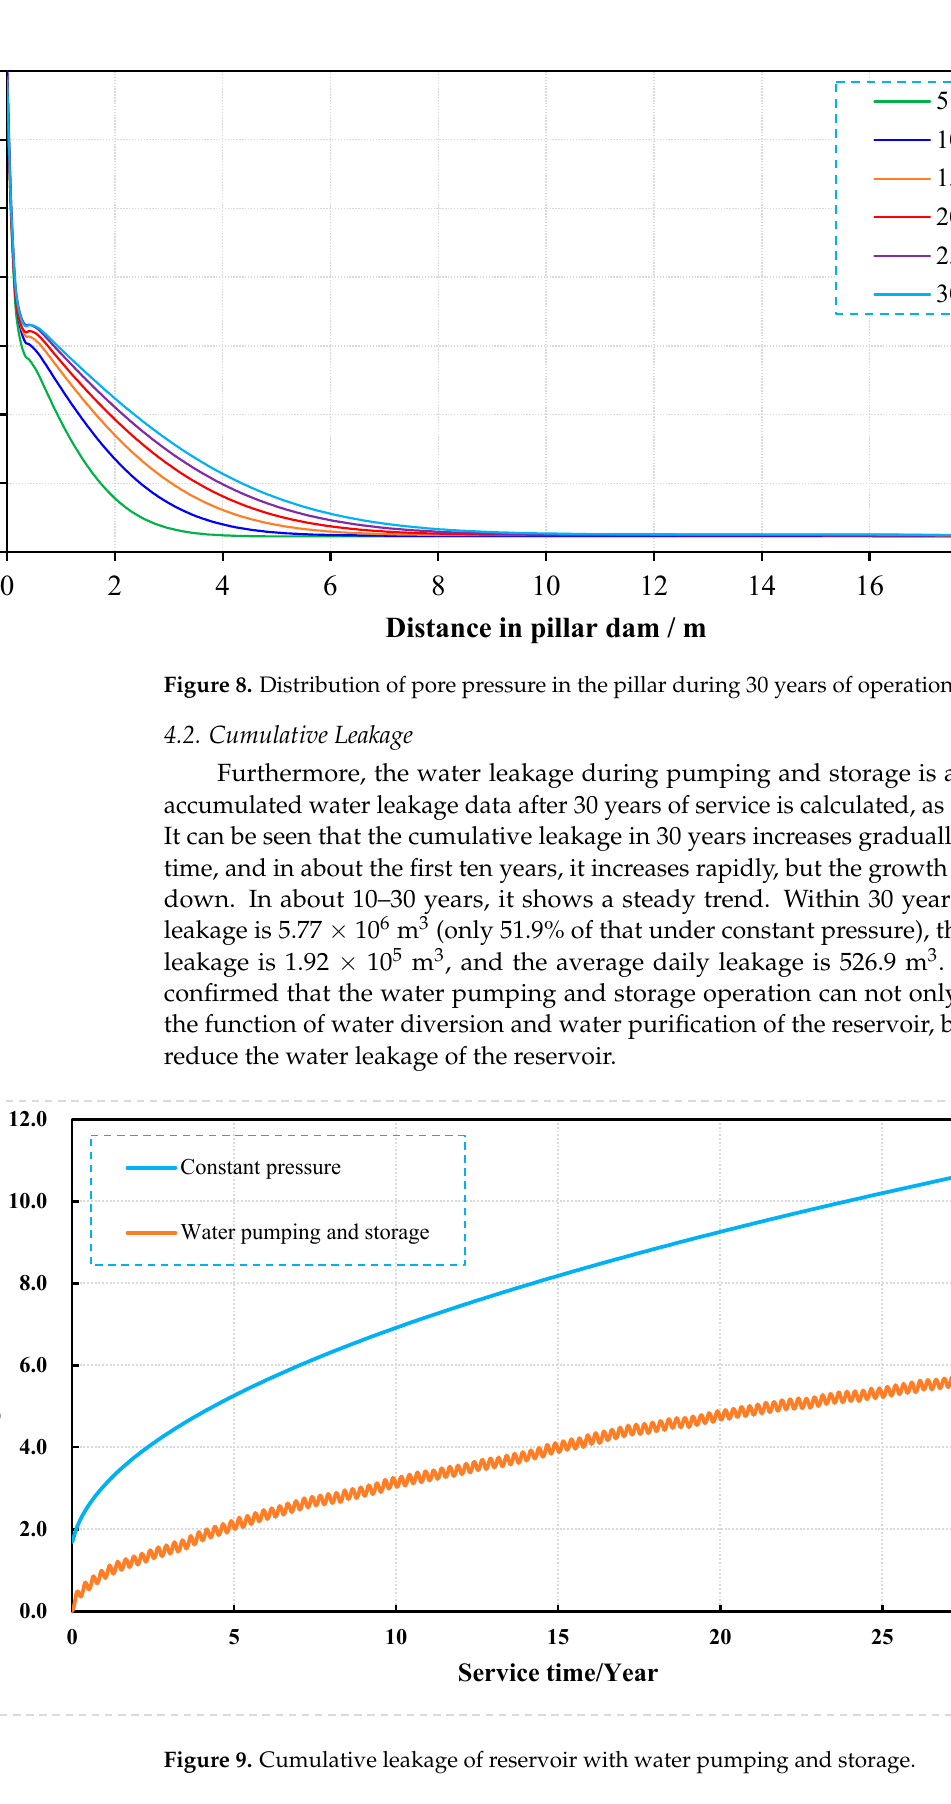
Figure 9. Cumulative leakage of reservoir with water pumping and storage.